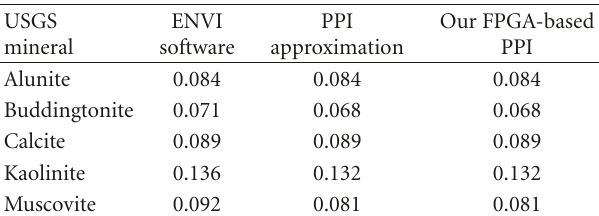
Table 1: Spectral angle-based similarity scores between the end- members extracted by di ff erent implementations of PPI and the selected USGS reference